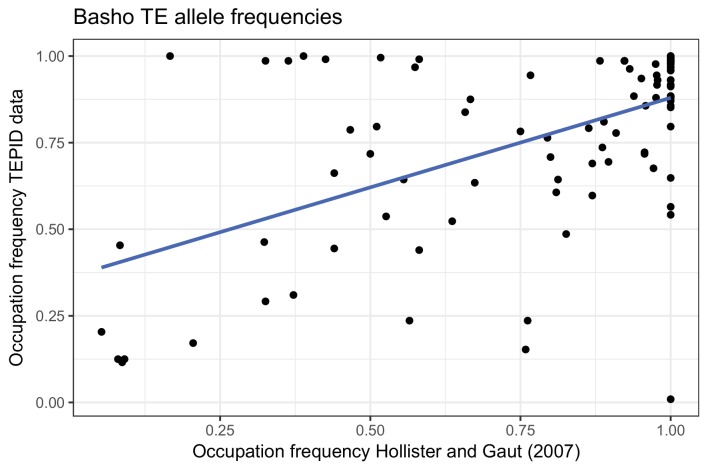
TE occupation frequencies for Basho TEs previously genotyped by (Hollister and Gaut, 2007).